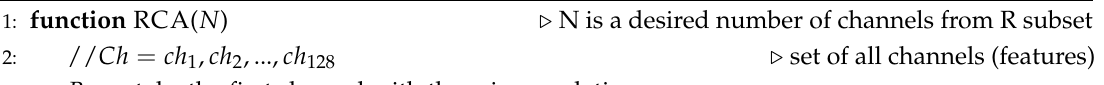
Algorithm 1. Reversed Correlation